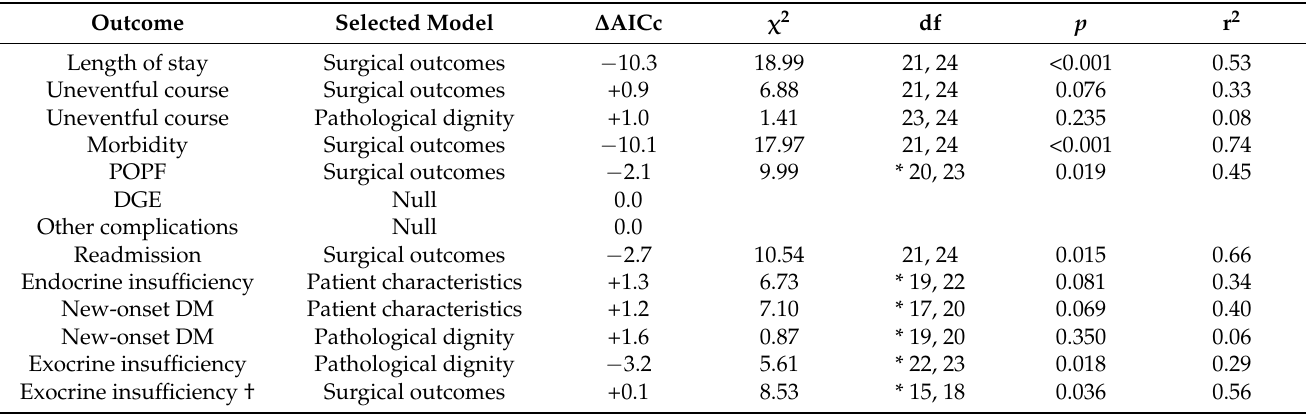
Table A5. Model selection results for each postoperative